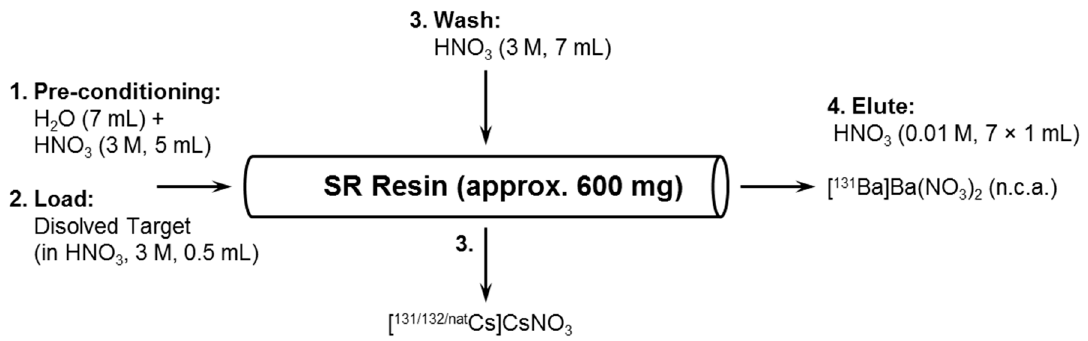
Figure 10. Method scheme for the separation of barium-131 from cesium impurities.